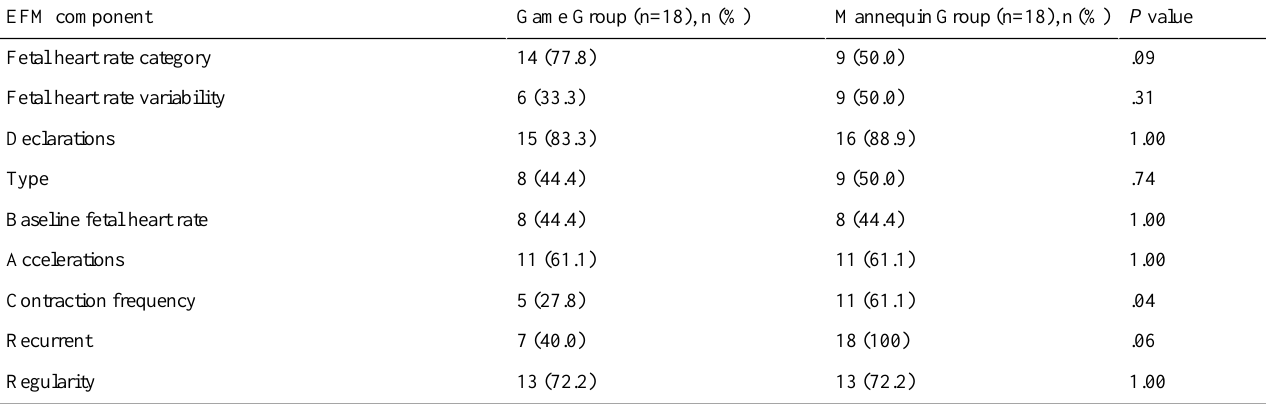
Table 2. Performance in Phase 2 by electronic fetal monitoring (EFM) component, shown as the number and percent of participants providing the correct